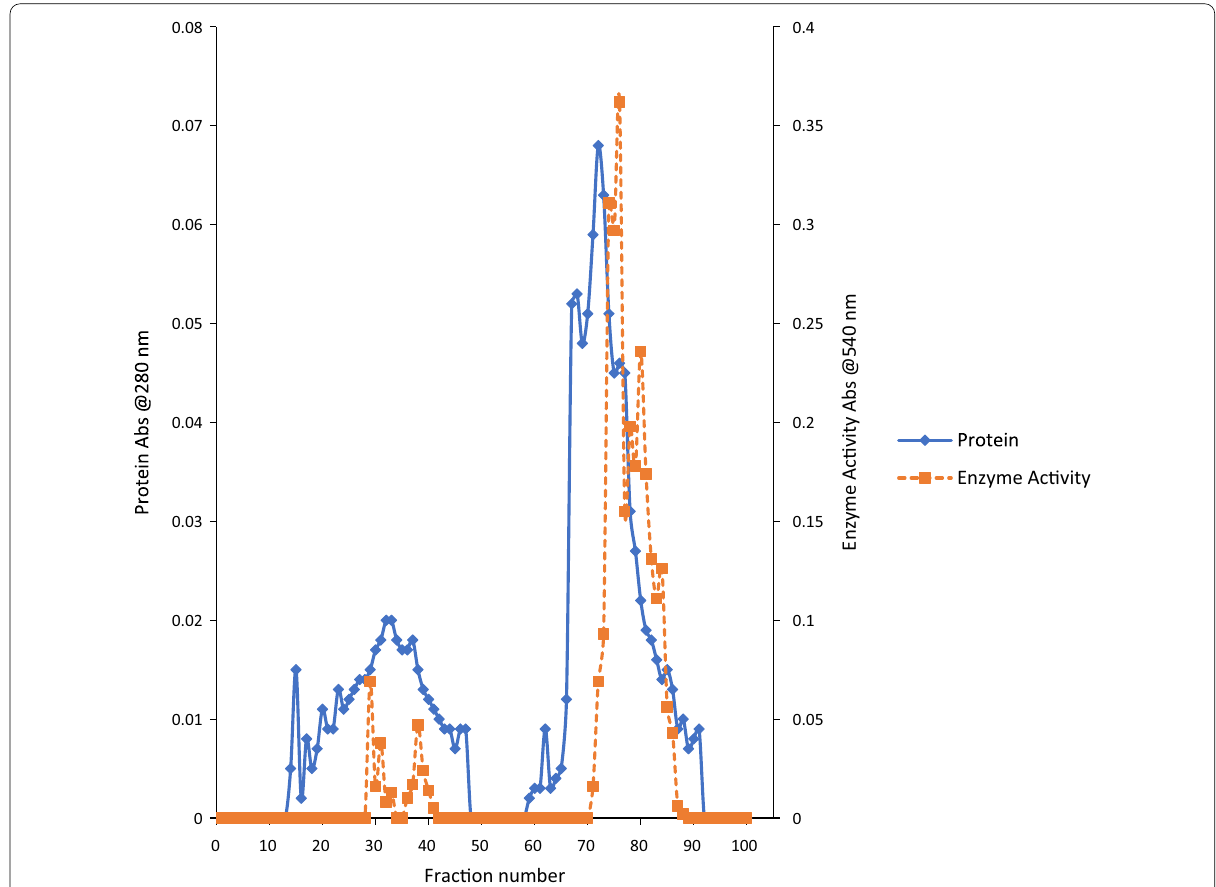
Fig. 8 Elution profile of chitinase produced by Streptomyces albus on ion exchange